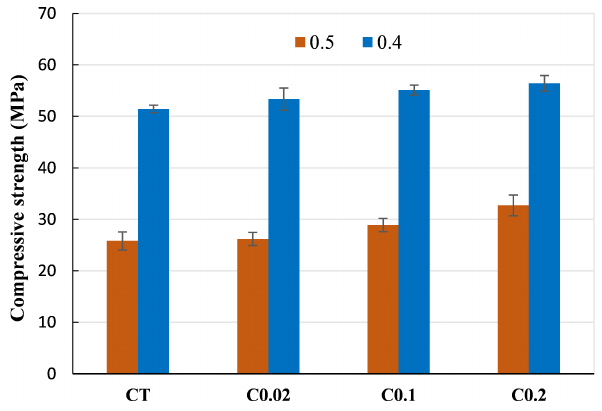
Figure 4: Compressive strengths of samples